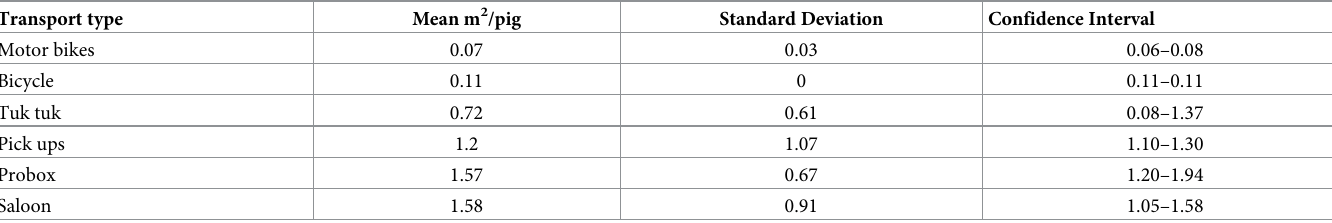
Table 3. Summary on loading density by transport